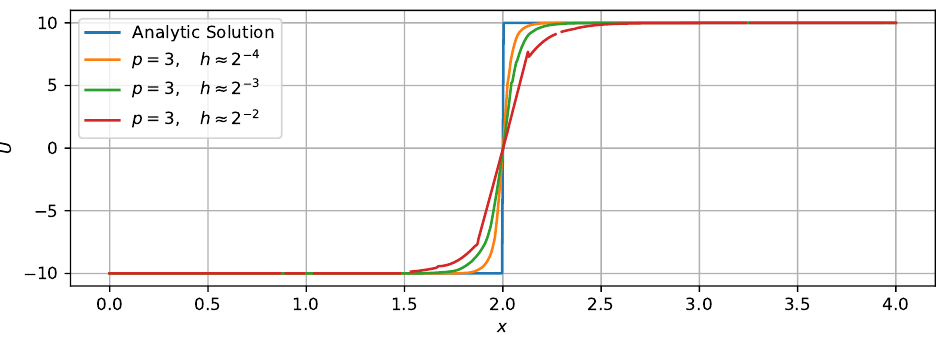
Figure 5. Comparison between solutions of Problem 1 given by running the same solver on different meshes.